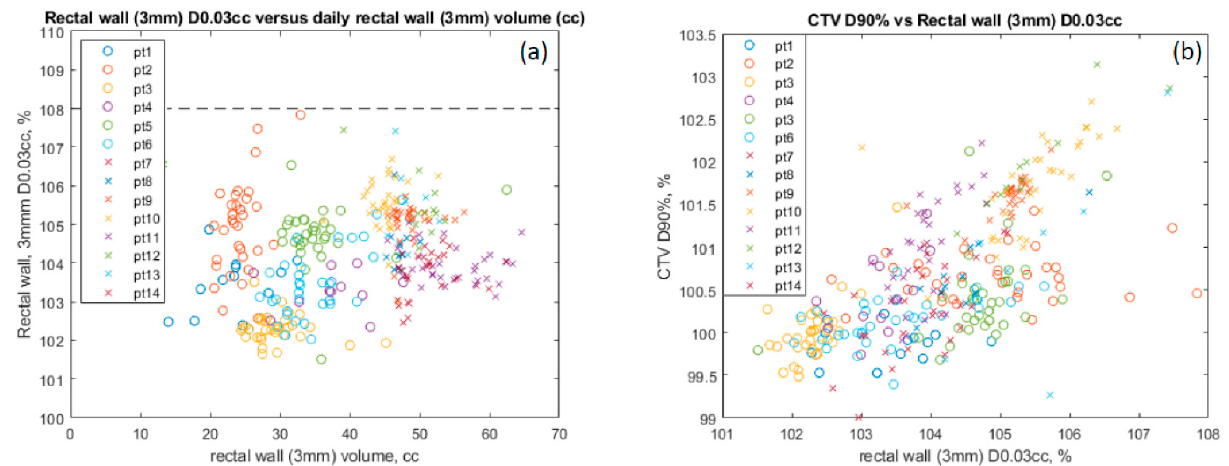
Figure 6. ( a ) Maximum rectal wall (3 mm) dose. ( b ) CTV D90% coverage vs. max rectal wall dose. Patients 1–6 (circle) use no endorectal balloons. Patients 7–14 (crosses) use endorectal balloons.